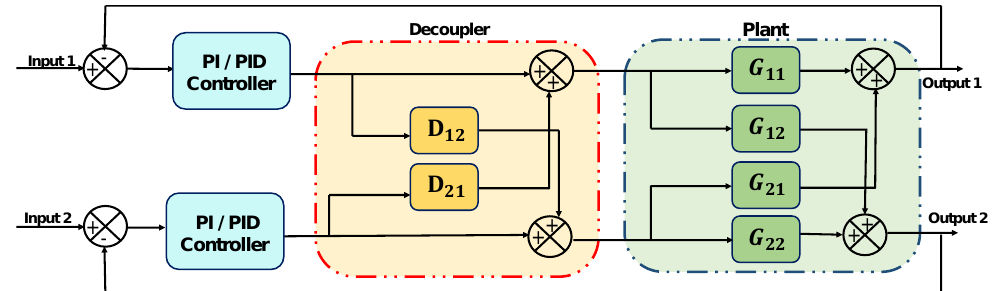
Figure 1. Closed loop decoupled structure for a TITO